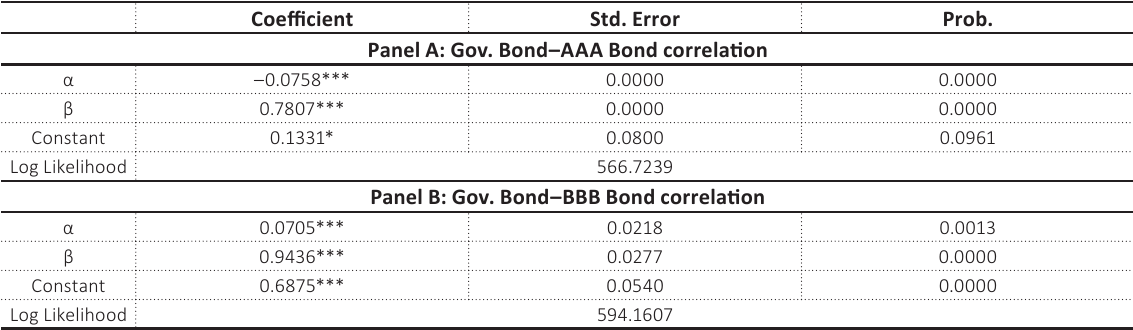
Table A1. Estimating the DCC-GARCH model Coefficient Std.